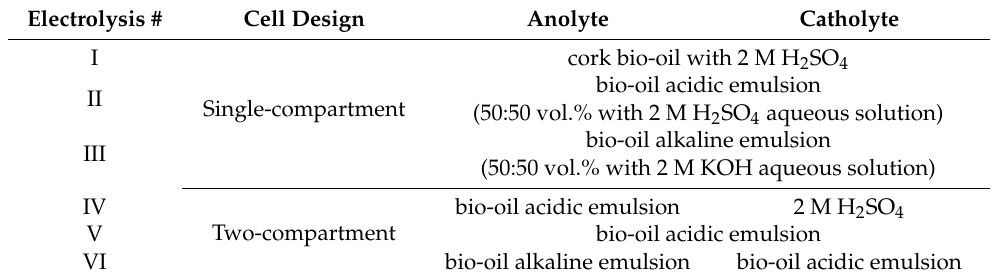
Table 1. Cell design and electrolyte compositions used in the cork bio-oil electrolysis experiments. Electrolysis